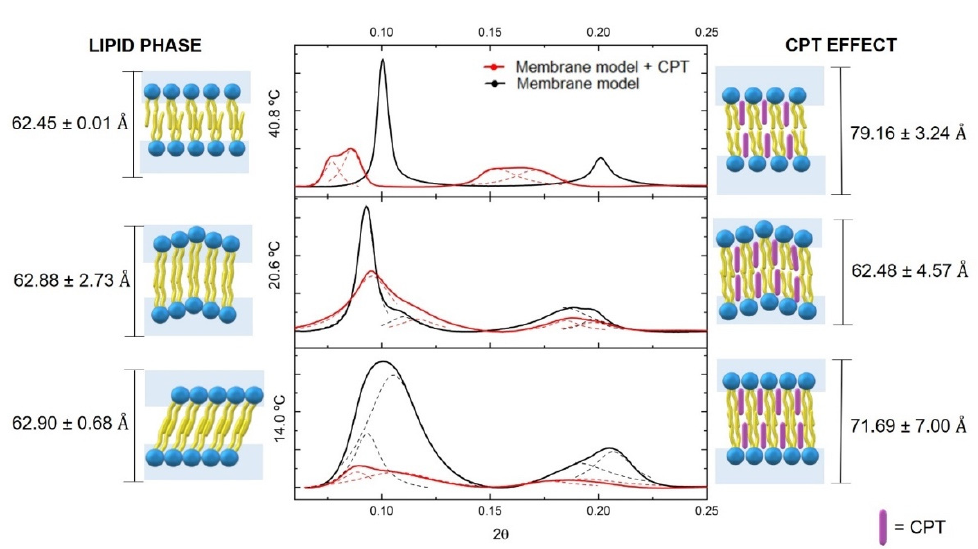
Figure 6. Small angle X-ray diffraction (SAXS) patterns of DMPC (black) or DMPC containing CPT (red) measured in the L β′ (14.0 °C), P β (20.6 °C), and L α (40.8 °C) phases of DMPC. Solid lines give the best fit of the Lorentzian’ s analysis model (dashed lines) to the scattered intensities. A model of the drug–membrane interaction is proposed for each diffractogram, together with the resultant d L values.